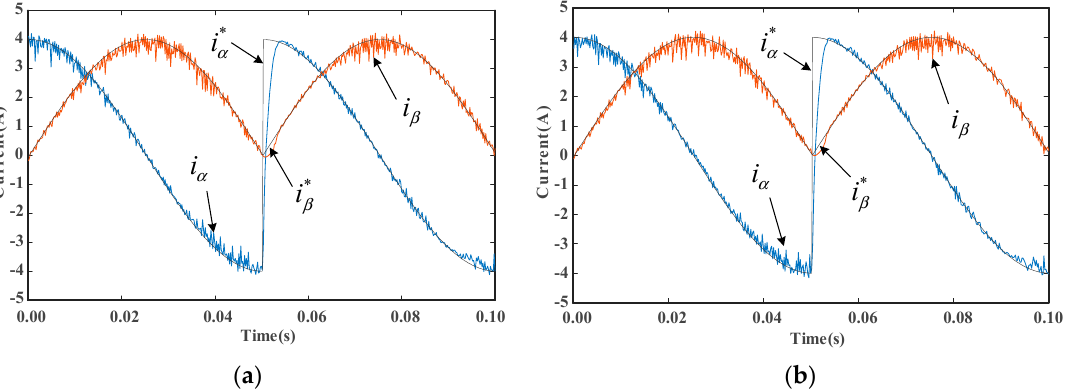
Figure 10. Transient response with abrupt current step from − 4 A to 4 A at 0.05 s in the 𝛼 -axis: ( a ) MPCC without modulation; ( b ) the proposed MMPCC.